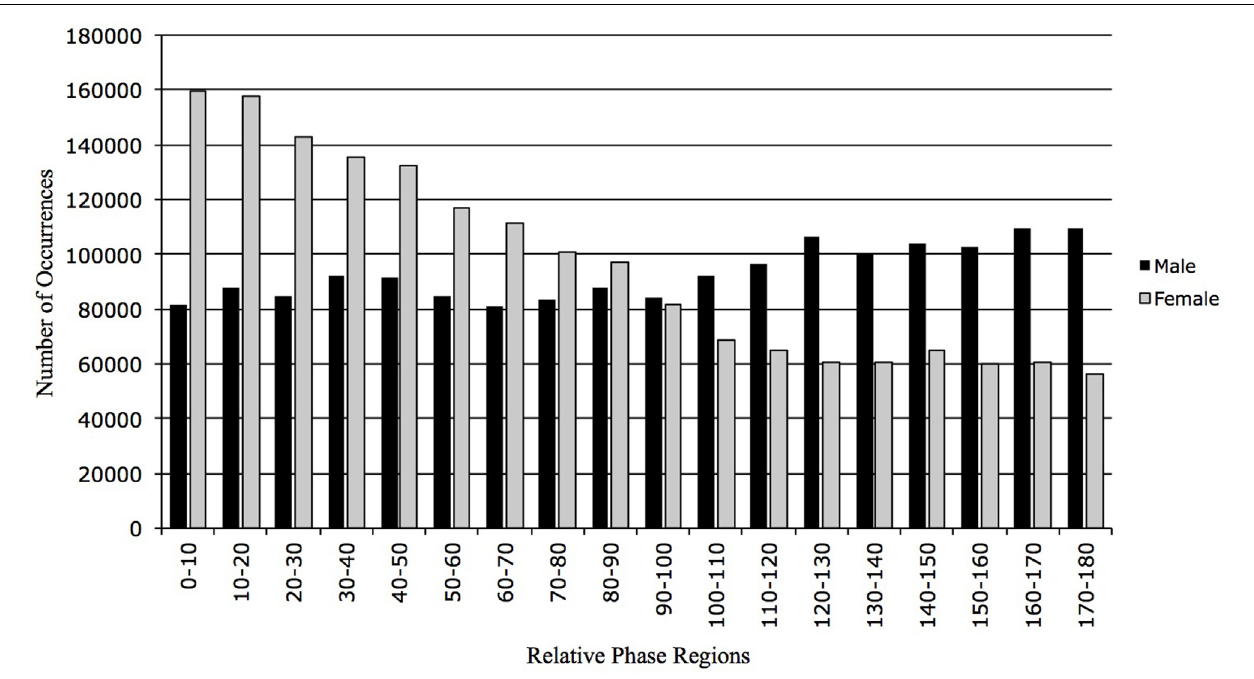
FIGURE 6 | Percentage distribution of number relative phase (NRP) occurrences for male and female. NRP is distributed in eighteen 10 ◦ regions from 0 to 180 ◦ .The female distribution is orientated toward 0 ◦ of RP whereas the male distribution is more evenly spread over the 18 regions of RP.